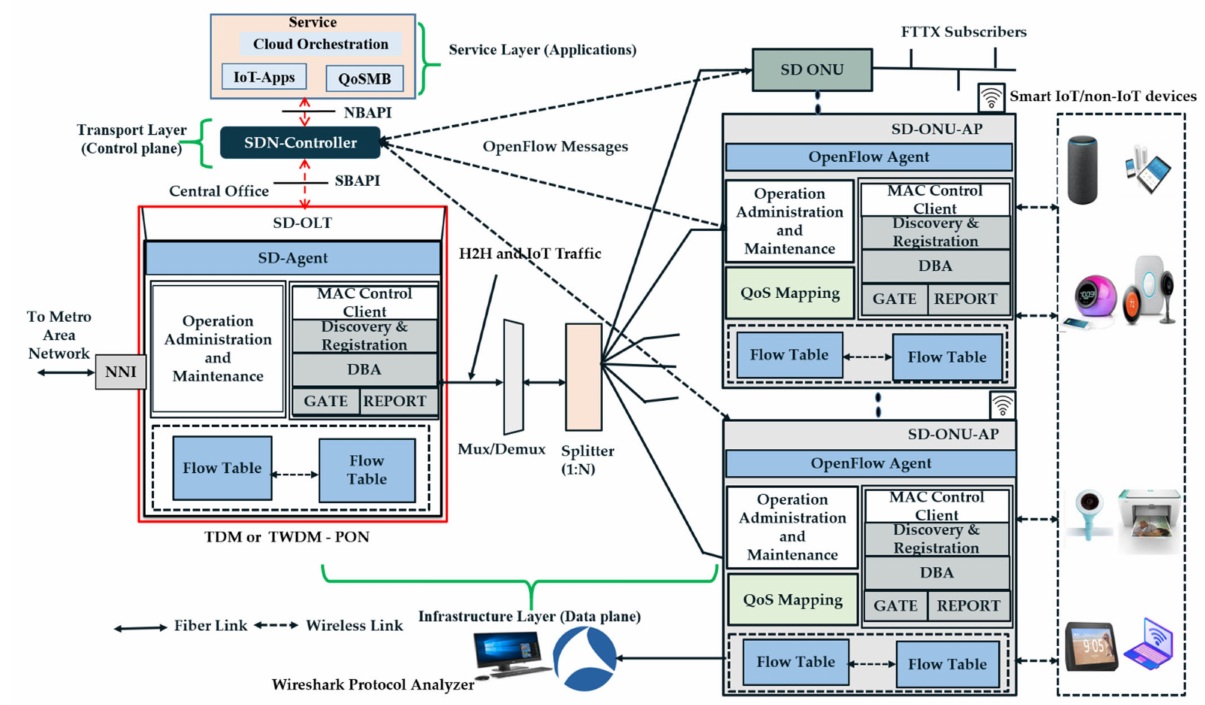
Figure 2. SDN-FiWi IoT network communication